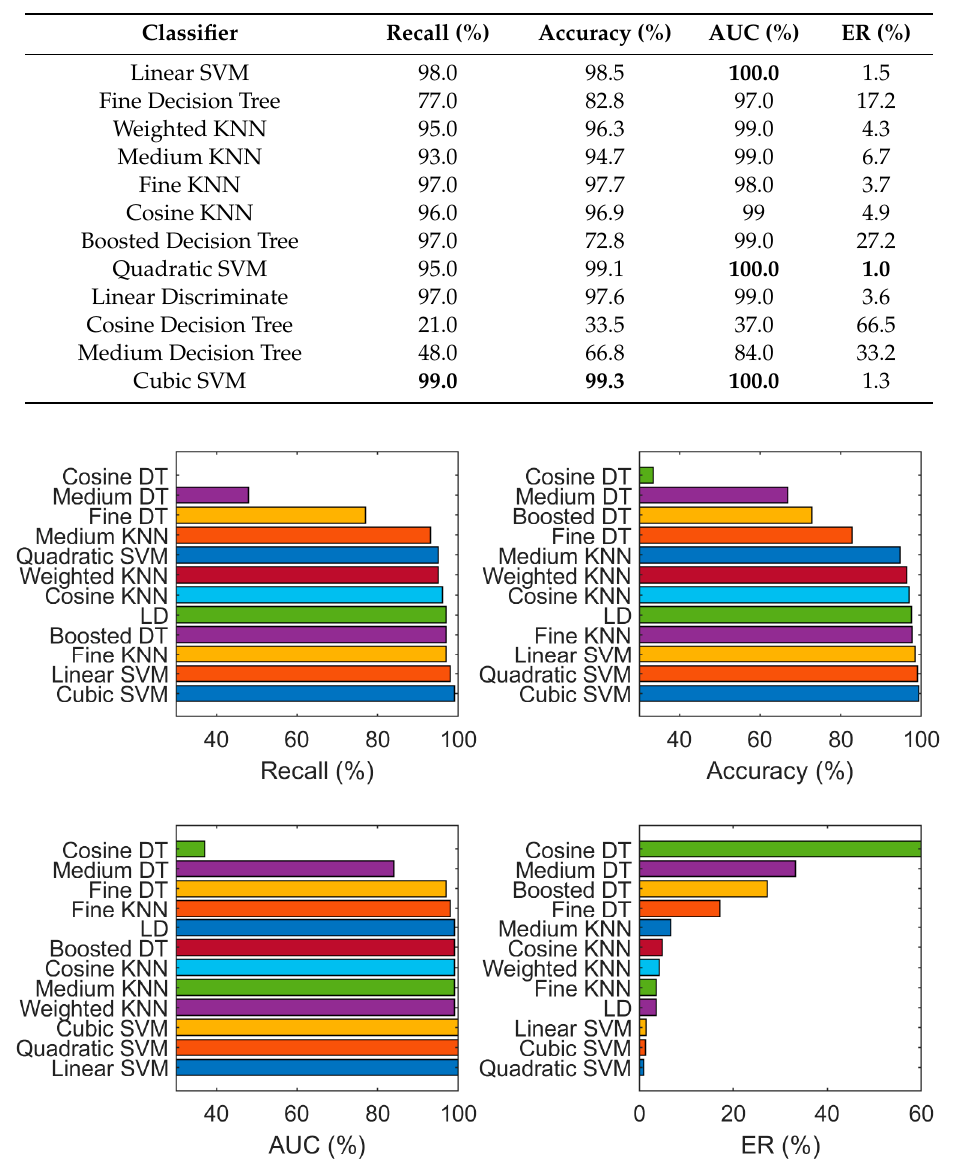
Table 6. Balanced (augmented) data with feature fusion of SFTA and a deep convolutional neural network (DCNN). Best values are shown in bold.